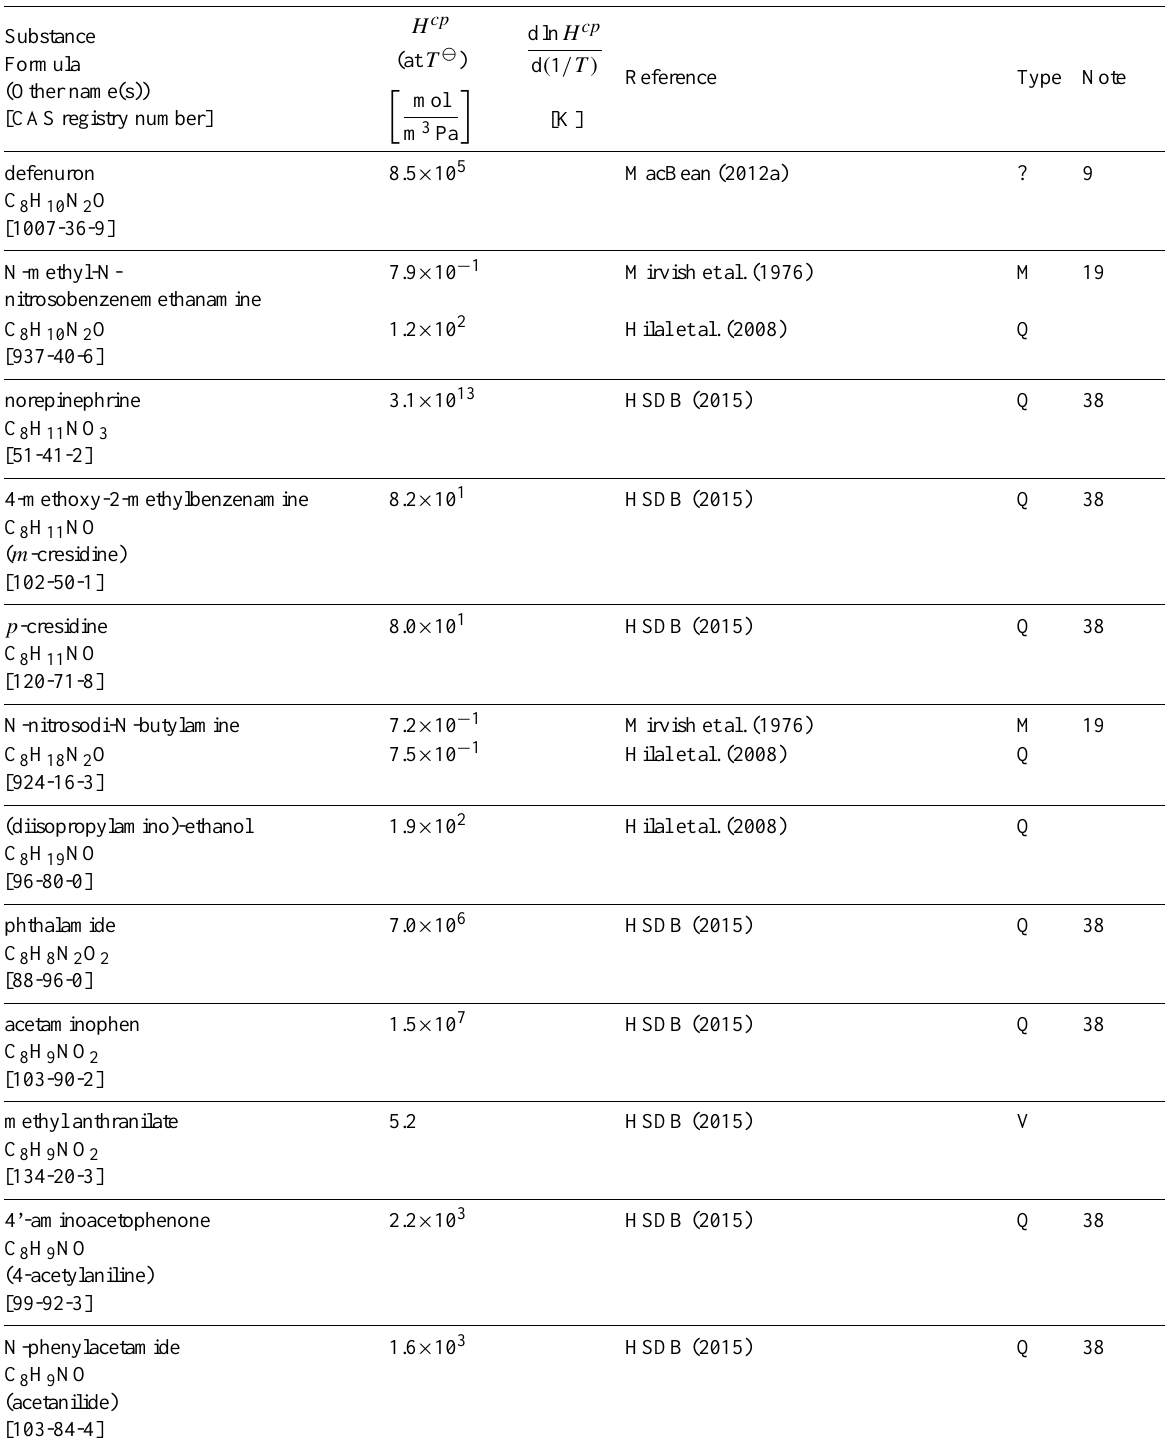
Table 6: Henry’s law constants for water as solvent